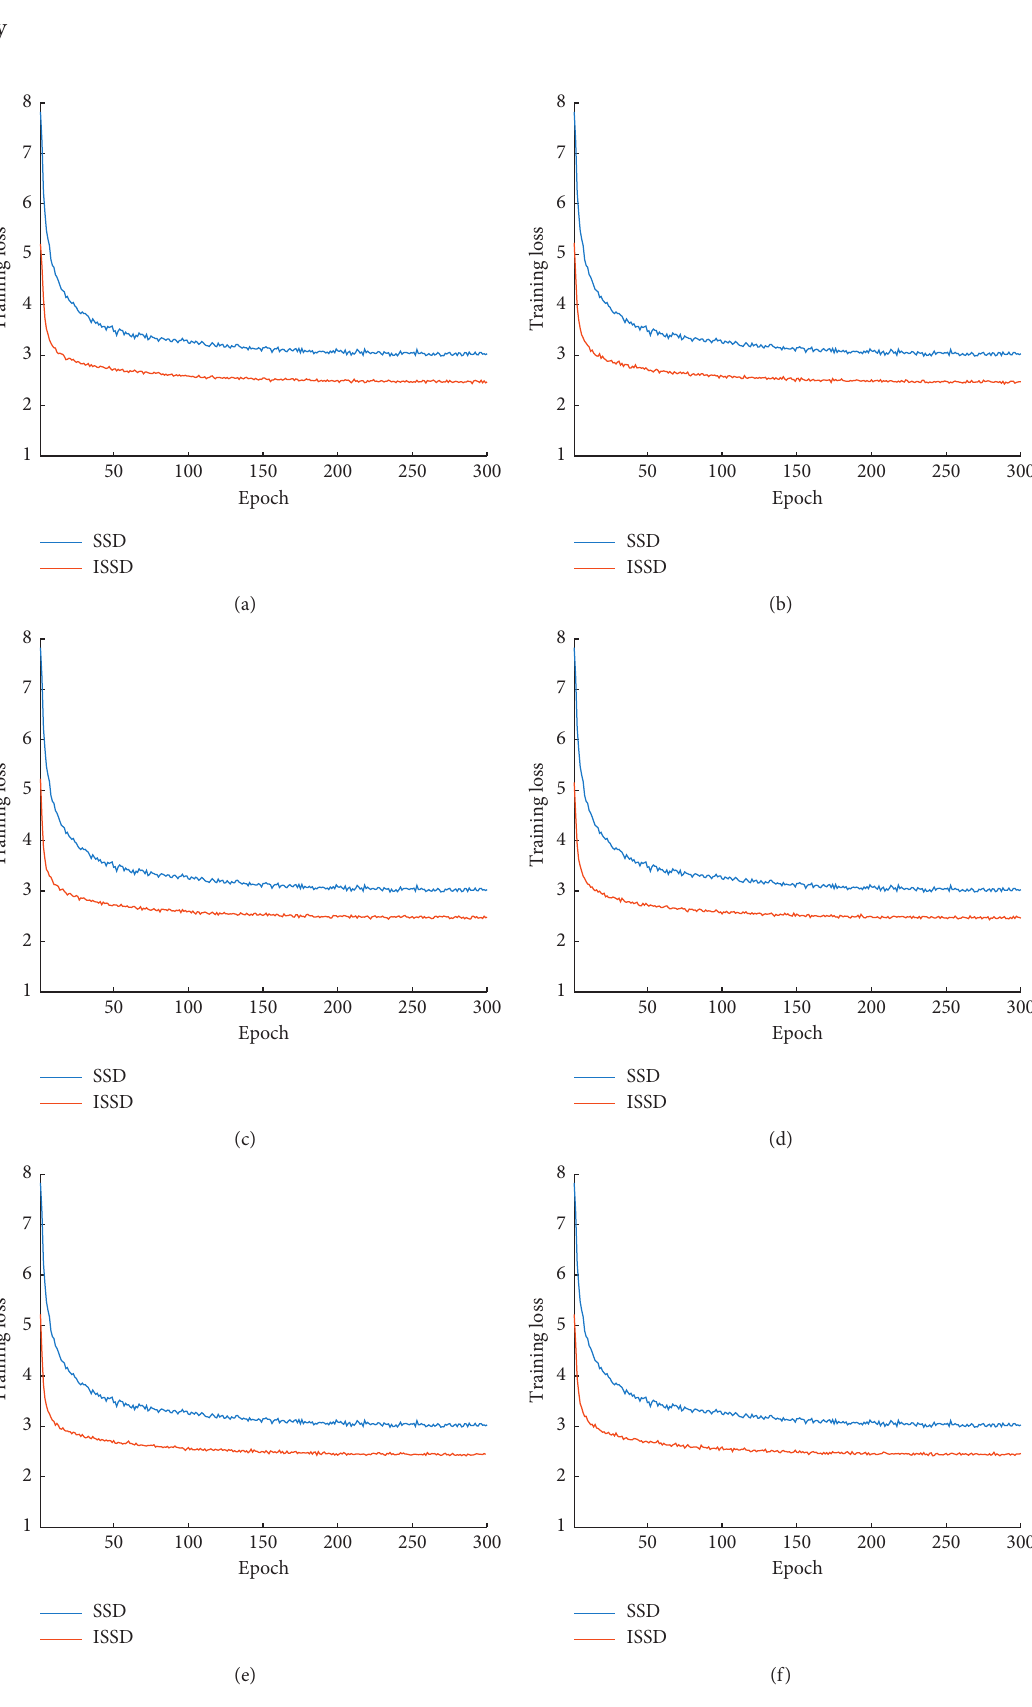
Figure 7: Comparison of loss functions of multidirection detections. (a) Loss function comparison of Laplace operator unidirectional. (b) Loss function comparison of Prewitt operator 2 directions. (c) Loss function comparison of Prewitt operator 4 directions. (d) Loss function comparison of Prewitt operator 8 directions. (e) Loss function comparison of Prewitt operator 16 directions. (f) Loss function comparison of Sobel operator 2